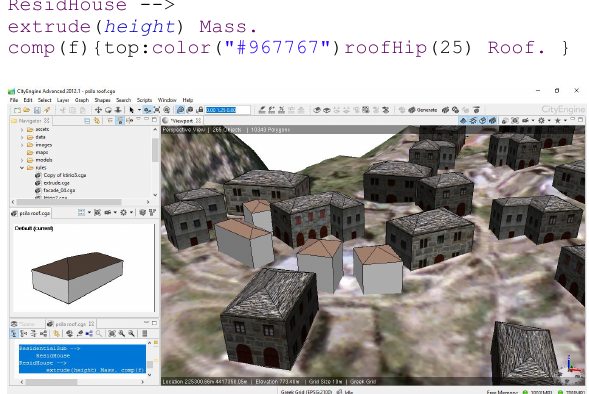
Figure 6. Lod1 models in CityEngine Viewport